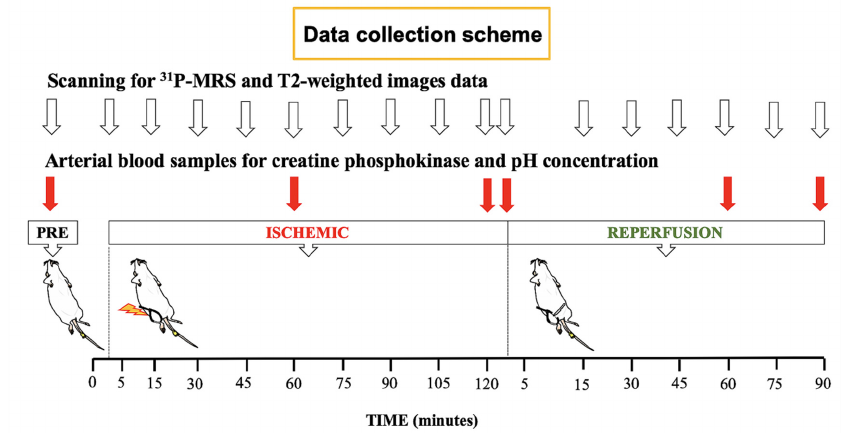
Figure 3. The experimental protocol. White arrows indicate the timings of data collection for phosphorus magnetic resonance spectroscopy ( 31 P-MRS) and T2-weighted images. Red arrows designate the time of arterial blood sampling for creatine phosphokinase and pH concentration. 31 P-MRS spectra were acquired at rest, during muscle compression (for 120 min) and reperfusion (for 90 min). During the magnetic resonance (MR) procedure, the concentration of pH and creatine phosphokinase (CPK) were analyzed from blood samples obtained from the tail artery.